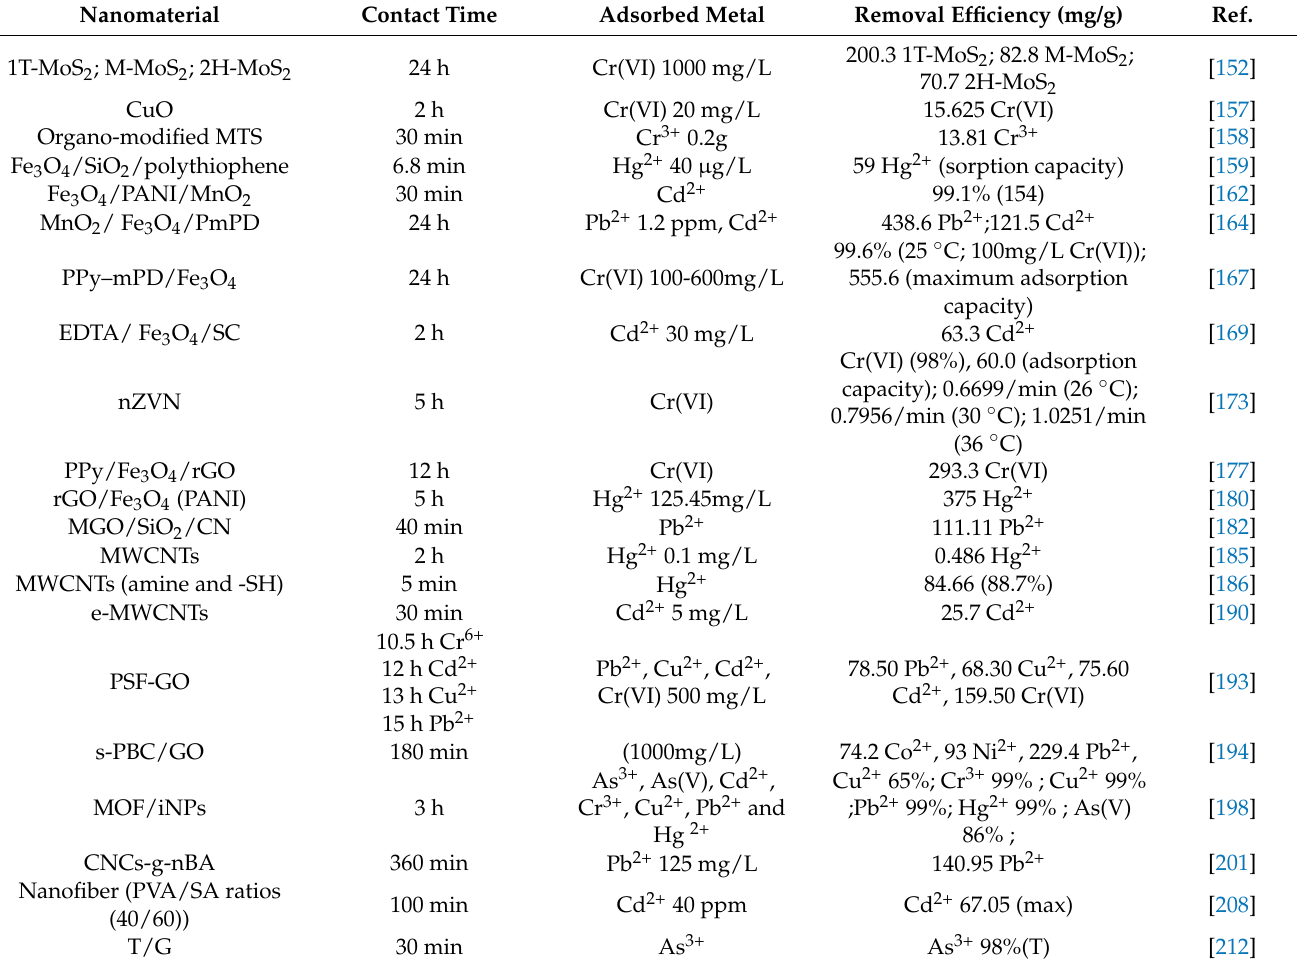
Table 6. Representative studies of heavy metal removal from food and water resources by